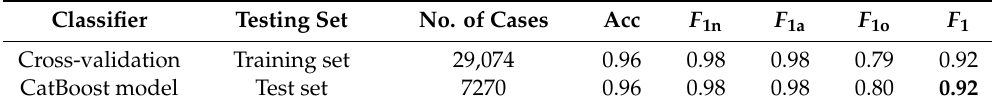
Figure 10. MCC scores according to different number of top-importance features. MCC = Matthews correlation coefficient. Table 6. Description of cross-validation scores and test